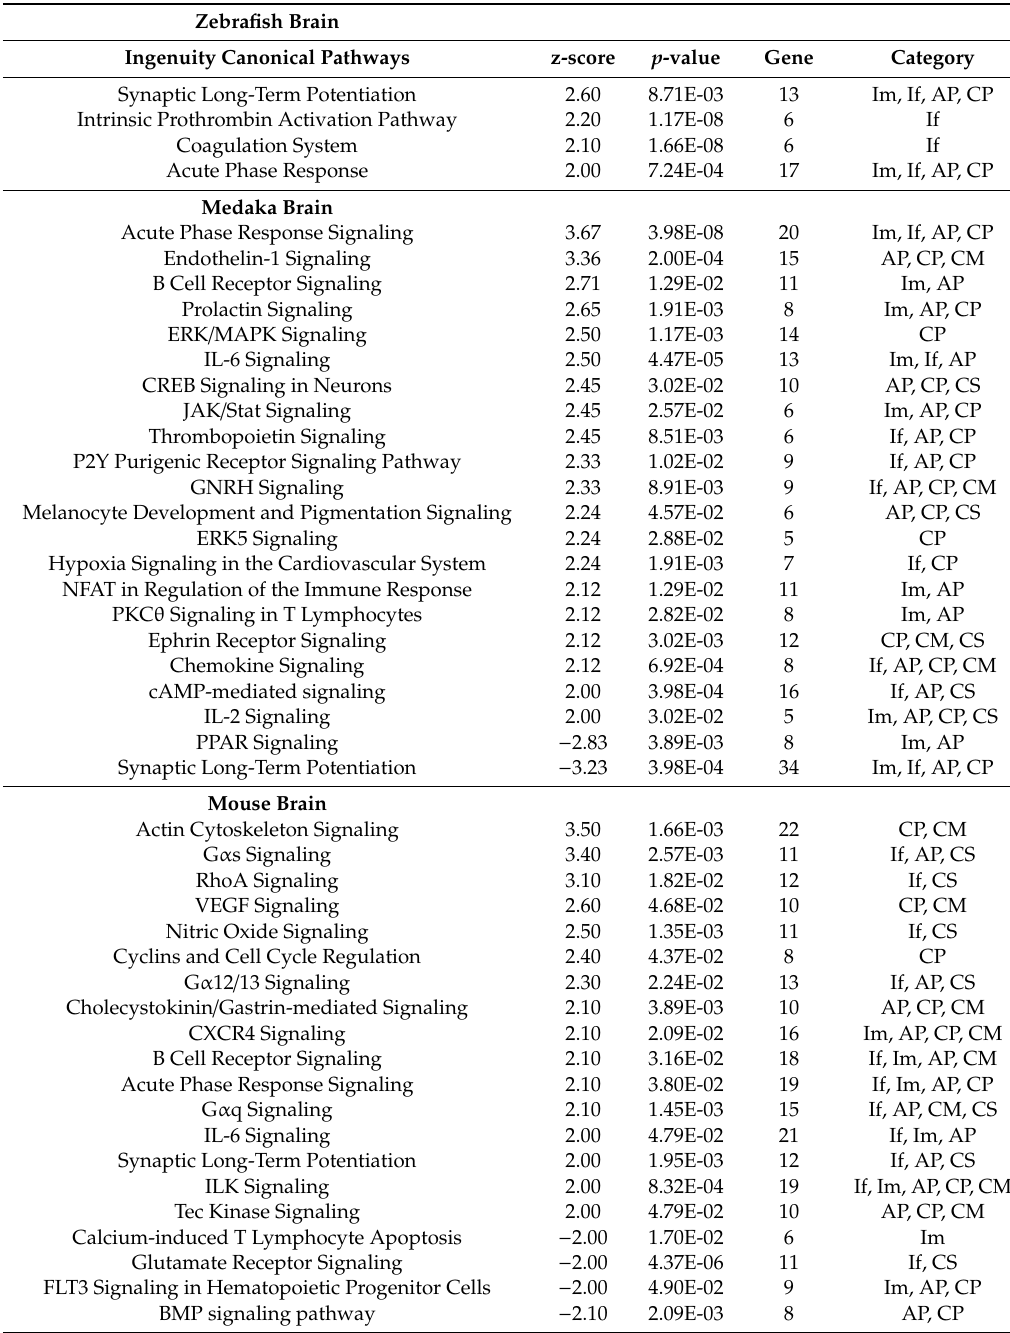
Table 3. Modulated canonical pathways were predicted using IPA for zebrafish (top), medaka (middle), and mouse (bottom) brain. All pathways with a z-score ≥ | 2 | , p -value < 0.05, and five or more genes were included in the analysis. The column on the far right indicates if the pathway is involved an immune (Im), inflammatory (If), acute phase (AP), cellular proliferation (CP), or cellular signaling (CS)